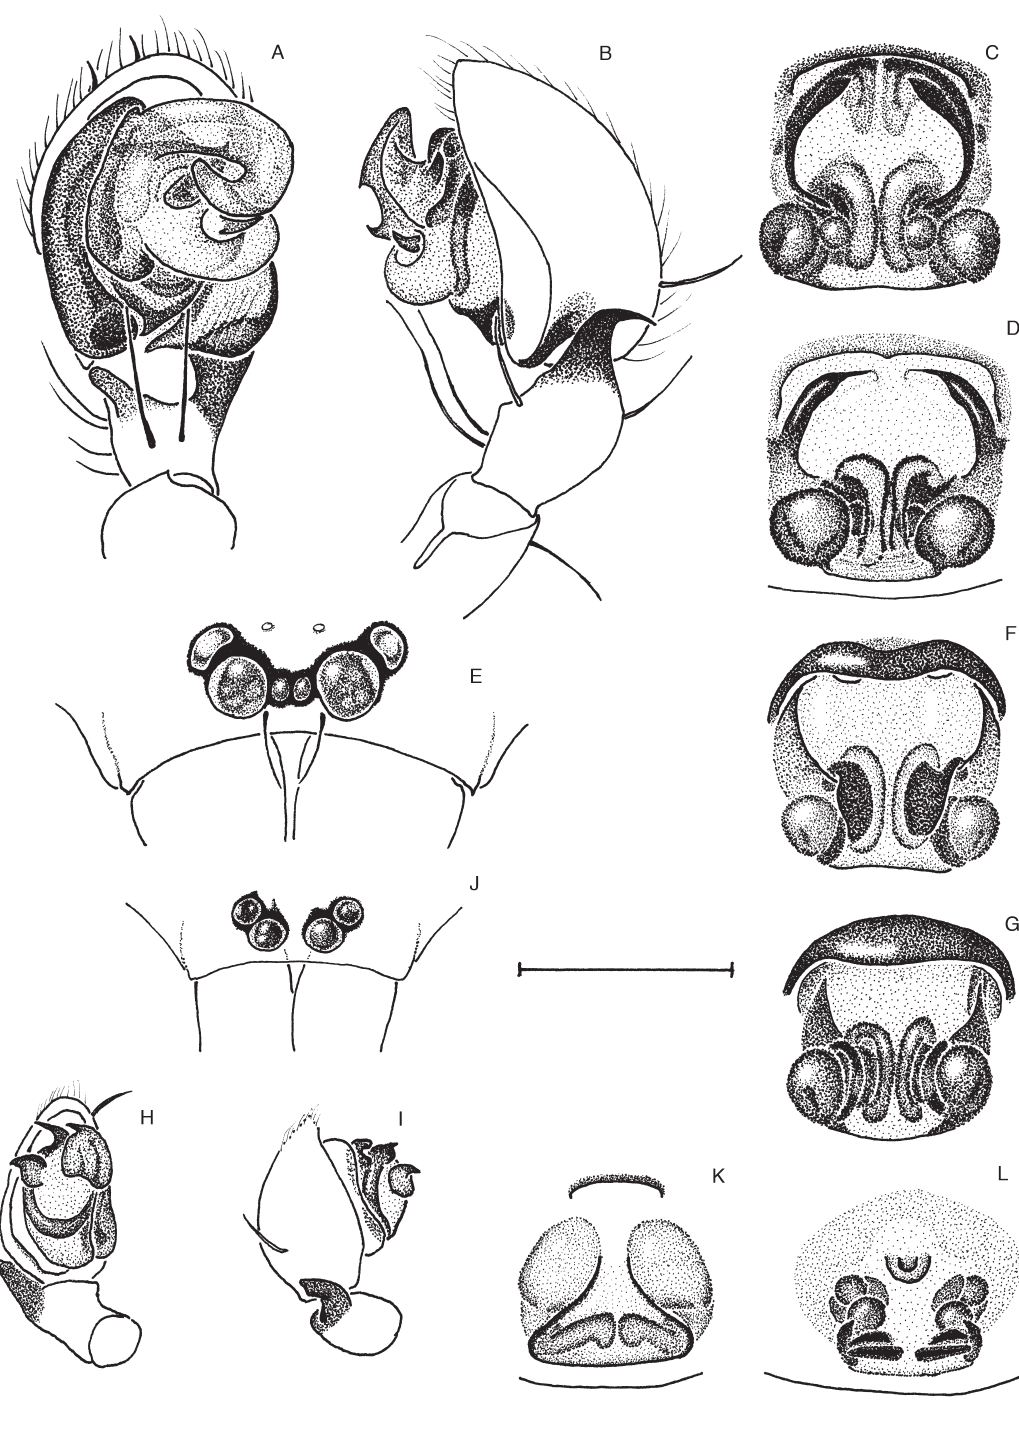
Fig. 12. A-E. Cteniogaster conviva sp. nov. A. ♂, palp, ventral view. B. Idem, retrolateral view. C. Epigyne, ventral view. D. Idem, other specimen. E. Eye region of male, anterior view. F-G. Cteniogaster sangarawe sp. nov. F. Epigyne, ventral view. G. Idem, other specimen. H-J. Cteniogaster nana sp. nov. H. ♂, palp, ventral view. I. Idem, retrolateral view. J. Eye region of male, anterior view. K. Cteniogaster taxorchis sp. nov. Epigyne, ventral view. L. Cteniogaster lampropus sp. nov. Epigyne, ventral view. Scale bar = 250